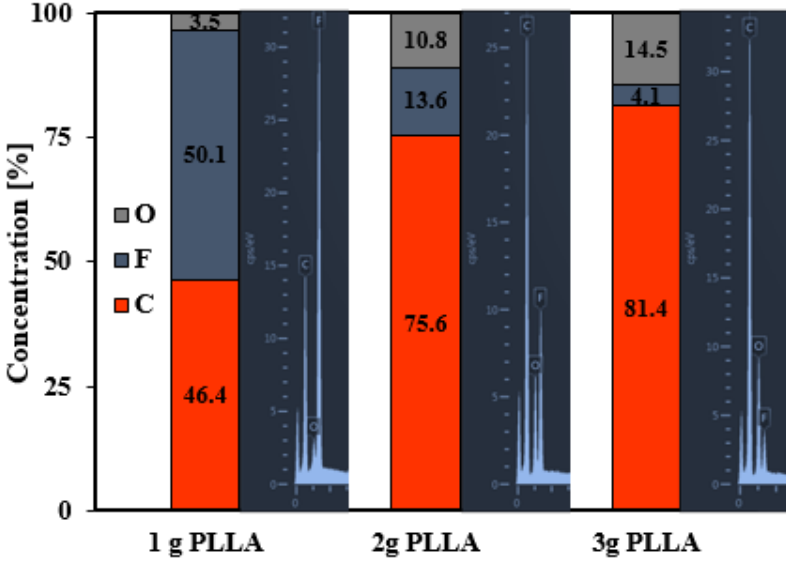
Figure 4. The surface concentration of elements (C, F, and O) on FEP foils modified at 8 W and 240 s and then immersed in polymer solution containing 1, 2, or 3 g of PLLA. The diagrams are presented with energy-dispersive X-ray spectroscopy (EDS) elemental signals.